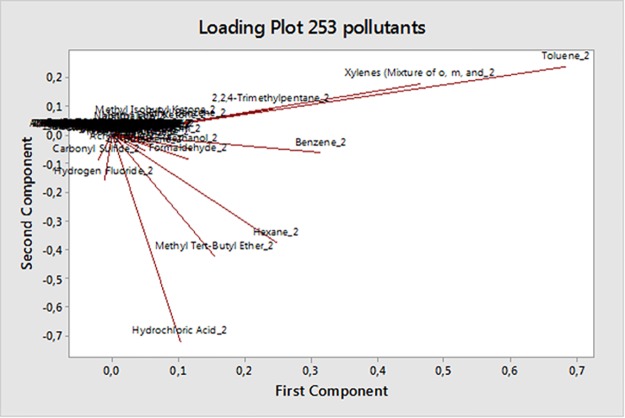
(A) Number of principal components and corresponding eigenvalue (%). (B) Loading plot for pollutants- PC2 vs PC1.